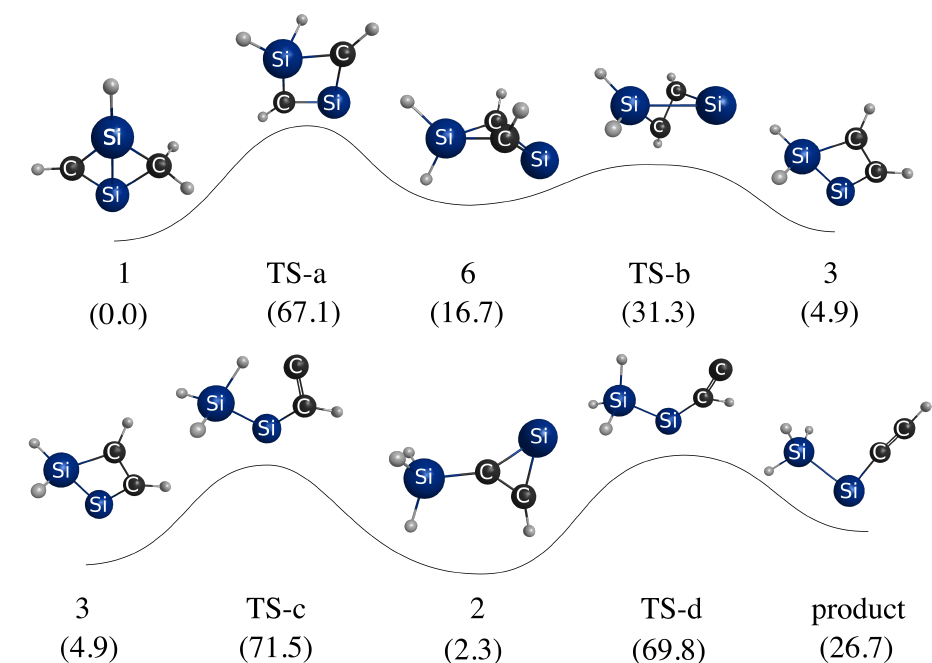
Figure 5. The stationary points connecting isomers 1 , 2 , 3 , 6 and ethynylsilylsilylene products, as optimized using B3LYP/DZP Relative energies are provided in parentheses in kcal/mol.